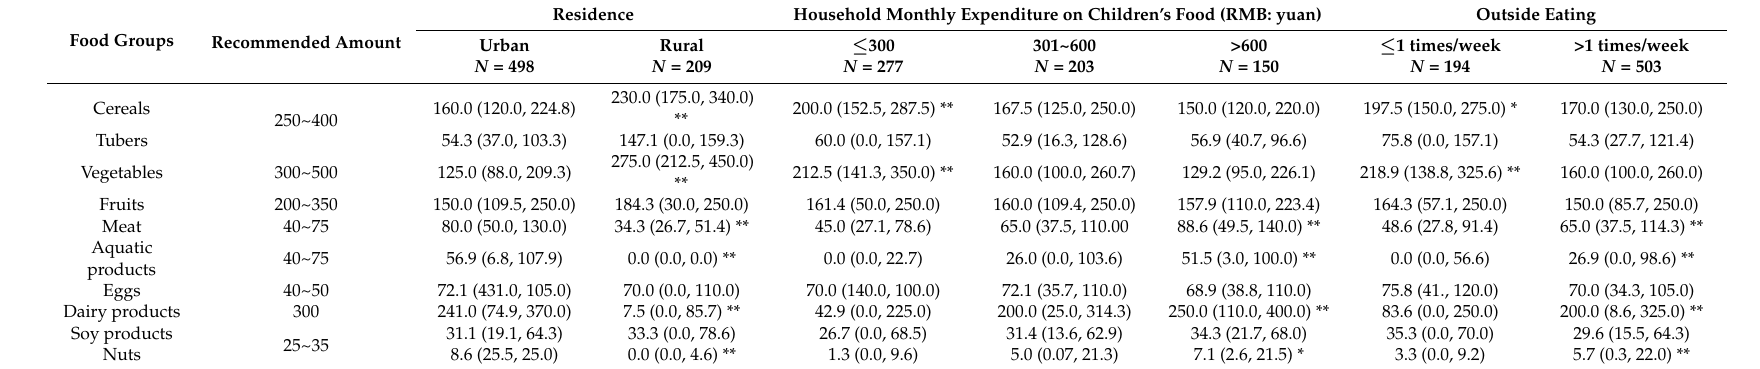
Table 5. Food daily intake among Chinese pre-school children with different characteristics